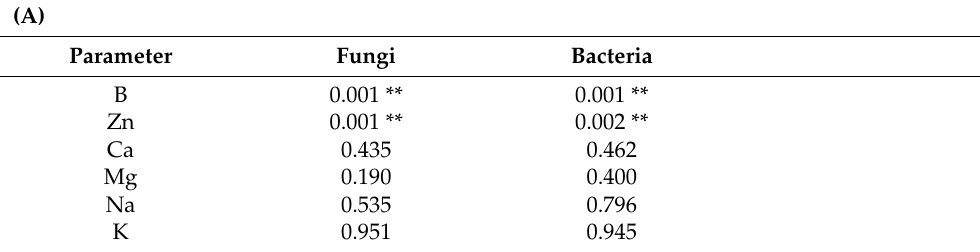
Table 4. ( A ) Significance level for NMDS ordination and environmental variables. two asterisks (**) represent statistically significant correlation ( p < 0.01). ( B ) The most important correlation between NMDS ordination and foliar parameters of